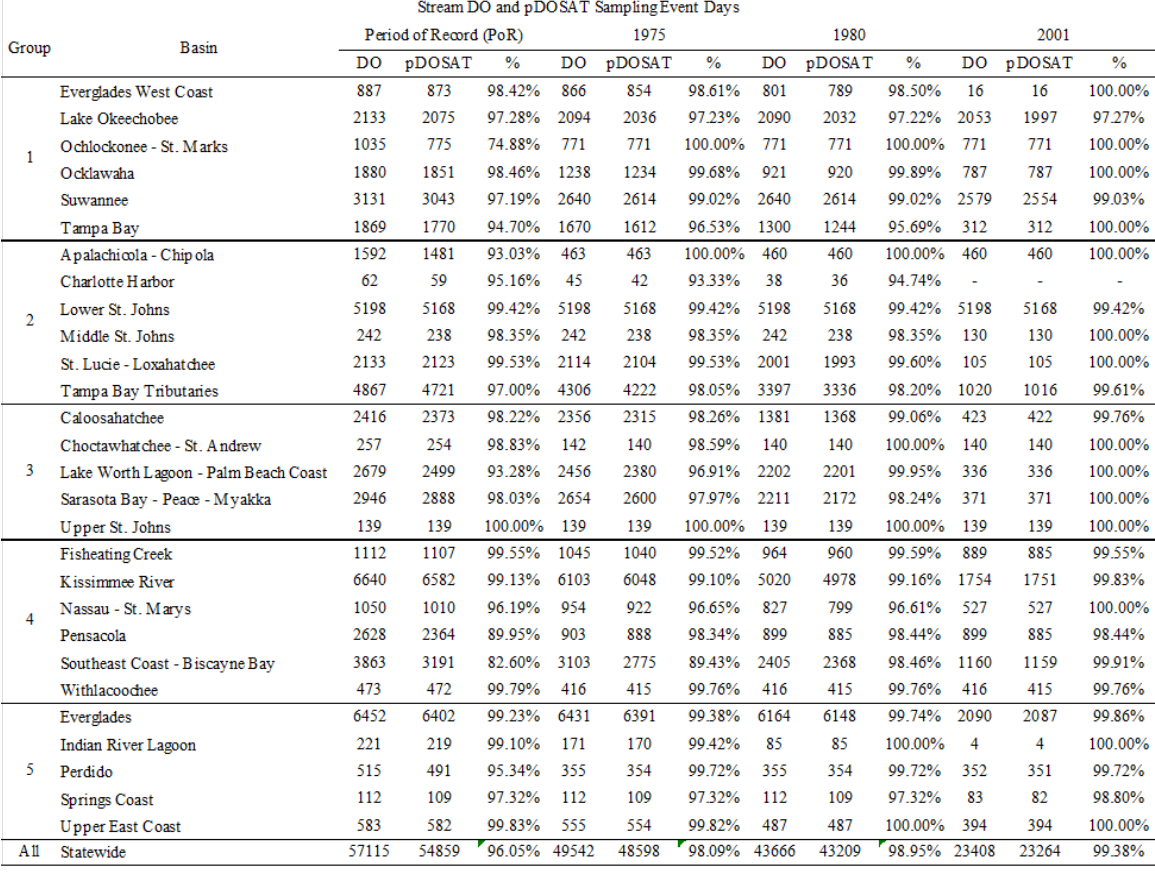
Table 2. Stream Sampling History. pDOSAT is represented here as n and % of